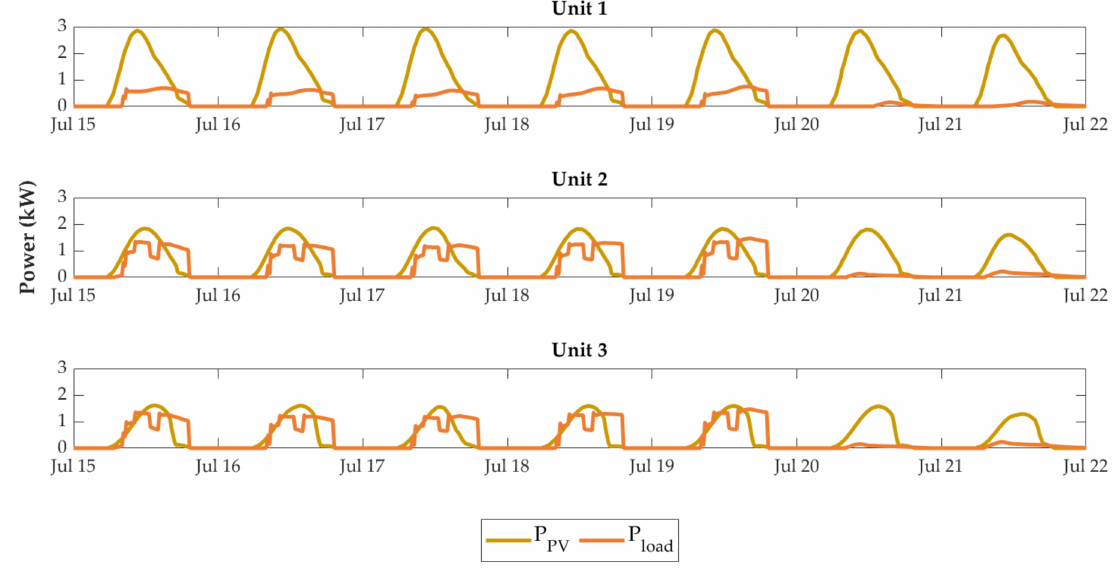
Figure 9. PV production and consumption power profiles of a typical summer week.